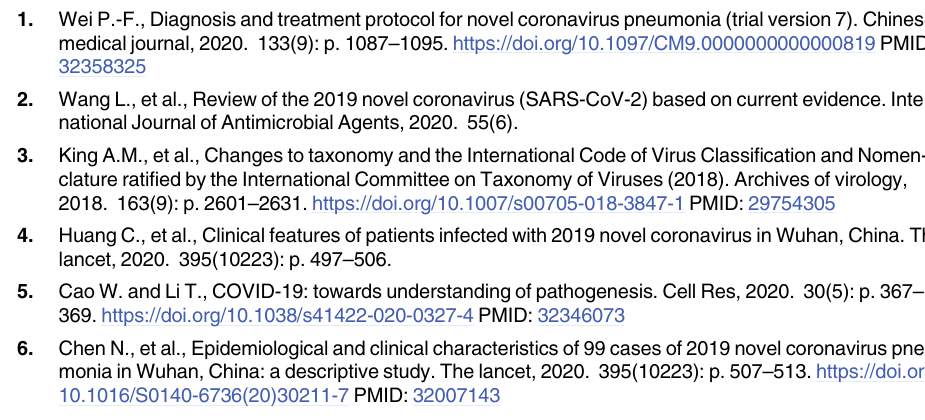
S1 Table. Comparison of the change of baseline basic coagulation with patient